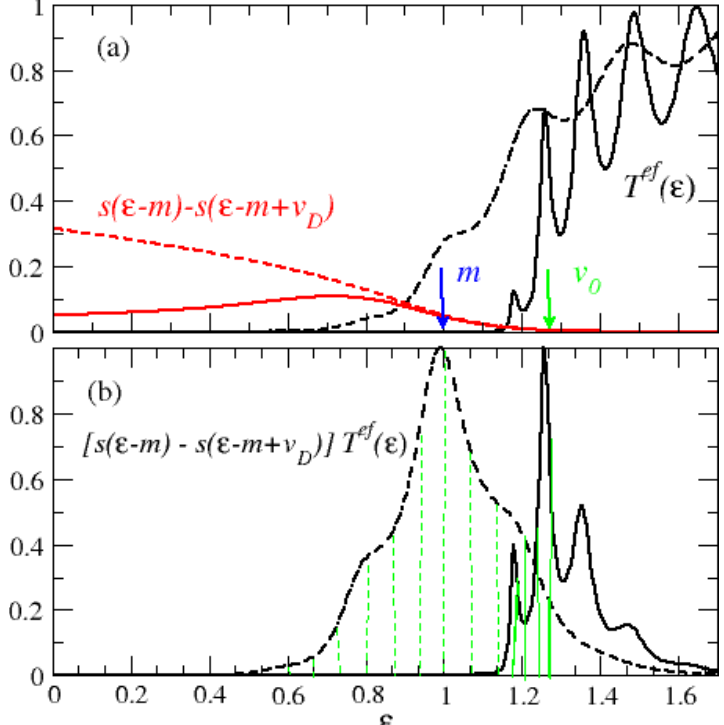
Figure 8. ( a ) Effective current transmission T ef ( (cid:101) ) (black) and supply function difference s ( (cid:101) − m ) − s ( (cid:101) − m + v D ) (red) for C2 in the OFF-state U G = 0.4 V at T = 298 K. Solid lines at the small drain voltage U D = 0.1 V and dashed lines at the large drain voltage U D = 0.95 V. At T = 298 K and U G = 0.4 V, one has from Figure 4 v 0 = 0.126 (green arrow) and m = 0.99 (blue arrow). In ( b ), the product T ef ( (cid:101) )[ s ( (cid:101) − m ) − s ( (cid:101) − m + v D )] is plotted normalized to its maximum in the energy range below v 0